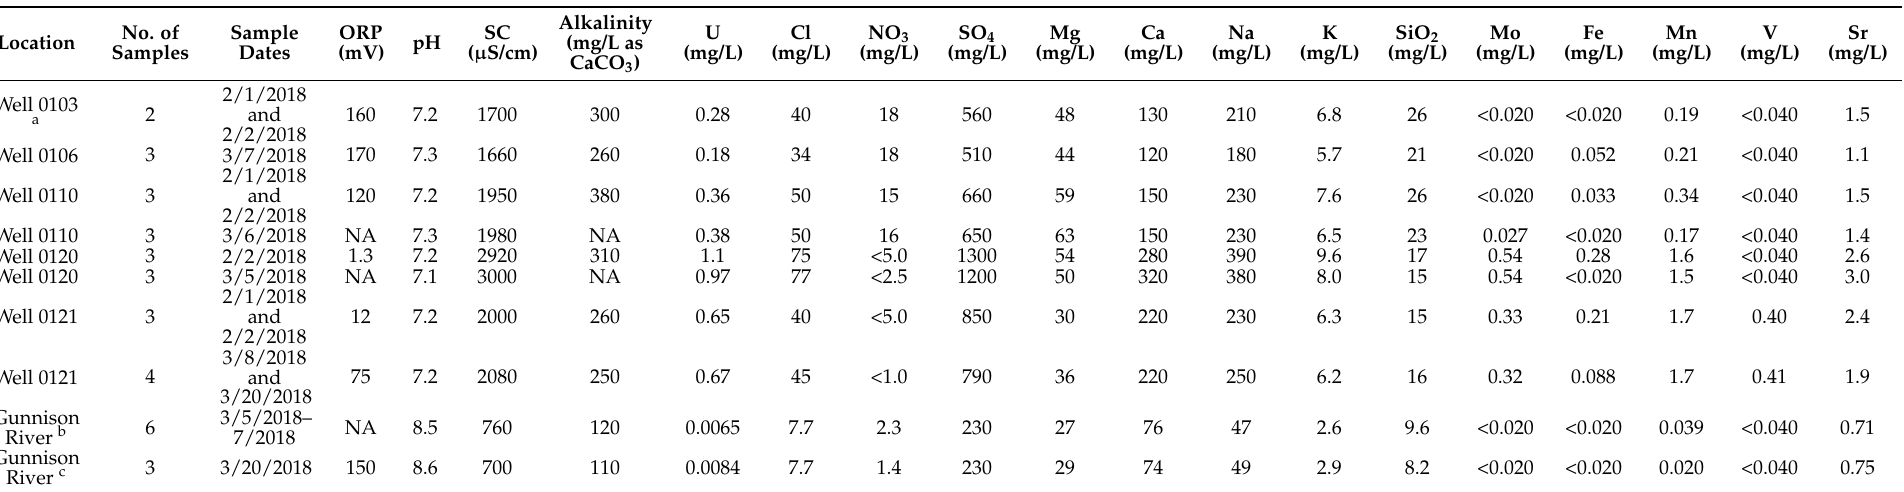
Table 2. Initial Geochemistry Before Tracer